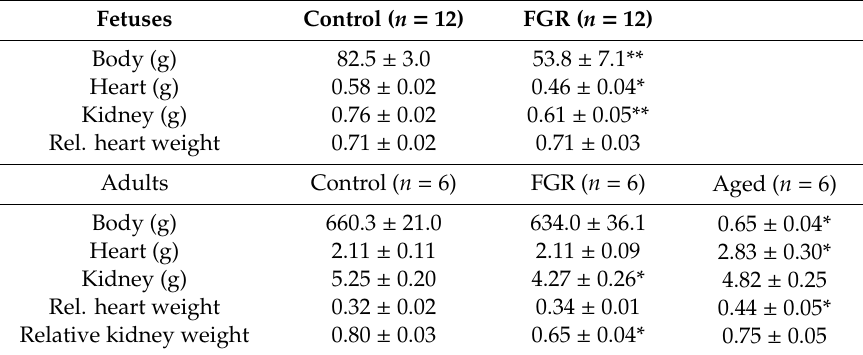
Table 1. Fetal, adult, and aged body, heart, and kidney weights.